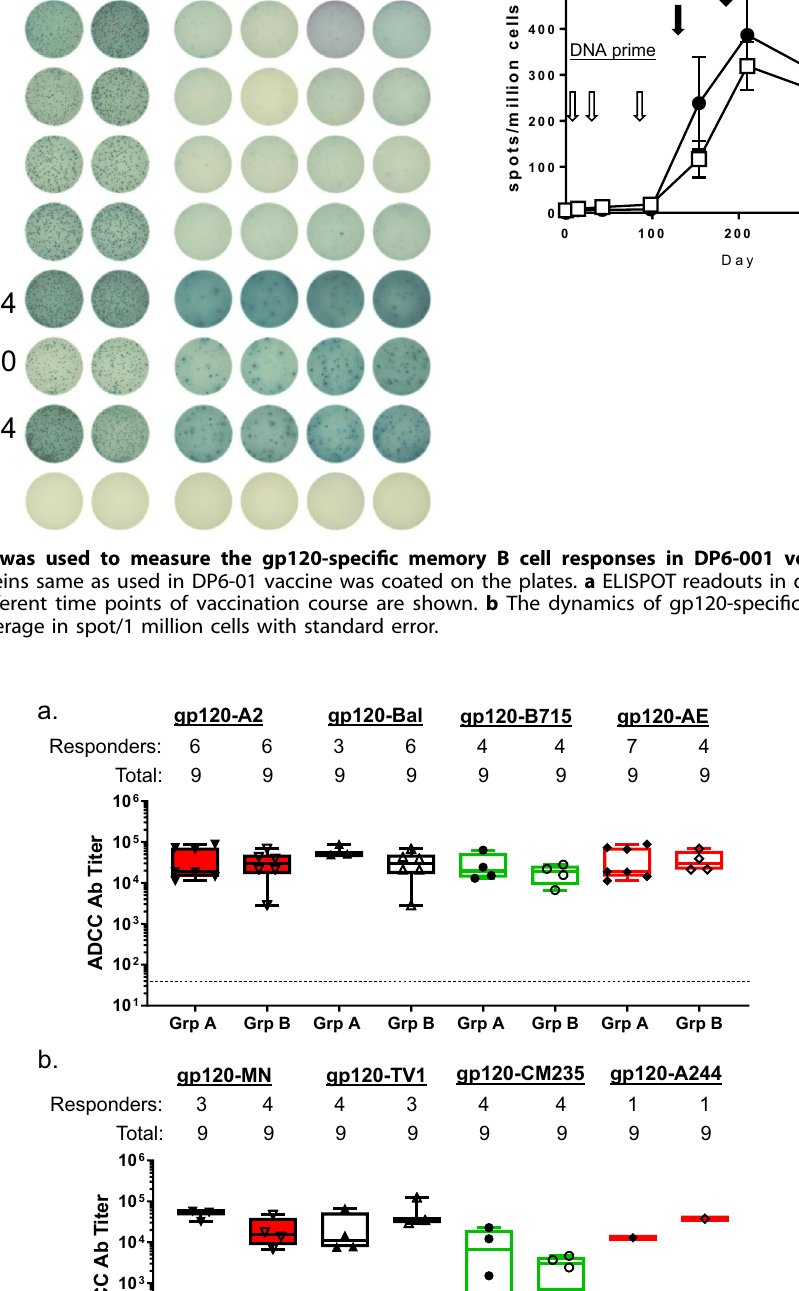
Fig. 6 Rate and magnitude of ADCC response against gp120-coated target cells in DP6-001 volunteer sera. ADCC-GTL assay was to detect ADCC against target cells coated either with the autologous gp120 proteins ( a ) or with the heterologous gp120 proteins ( b ). The numbers of positive responders and total volunteers are shown above the plots. The cut-off line is shown and the negative responders below the cut-off level were not included in the magnitude